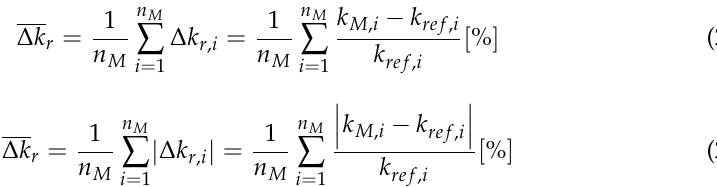
(cid:12) ∆ k (cid:12) (cid:12)